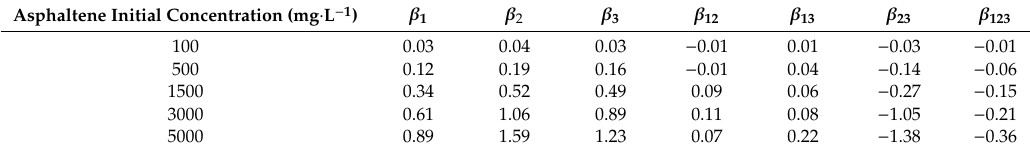
Table 5. Coe ffi cients of the Special Cubic Model for mixture design with Si-Fe-Mo.